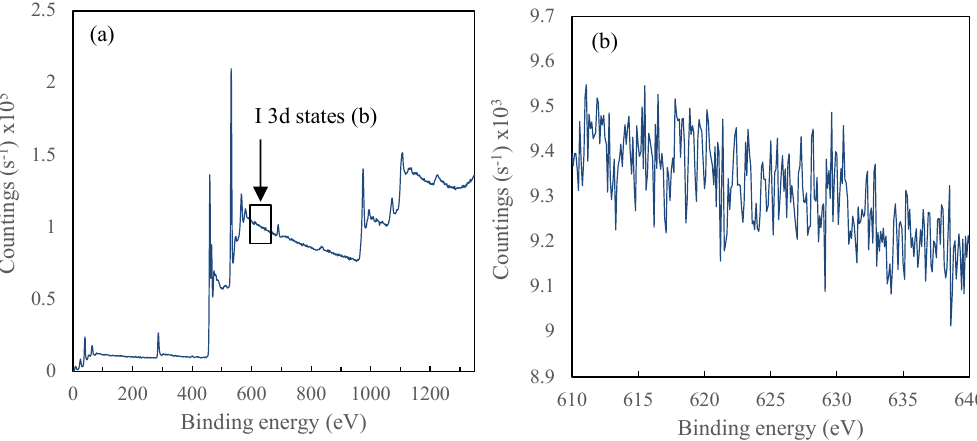
Figure 12. XPS analyses spectra for TBT-HIO 3 _20 sample ( a ) with the I 3d states binding energy enlargement ( b ).